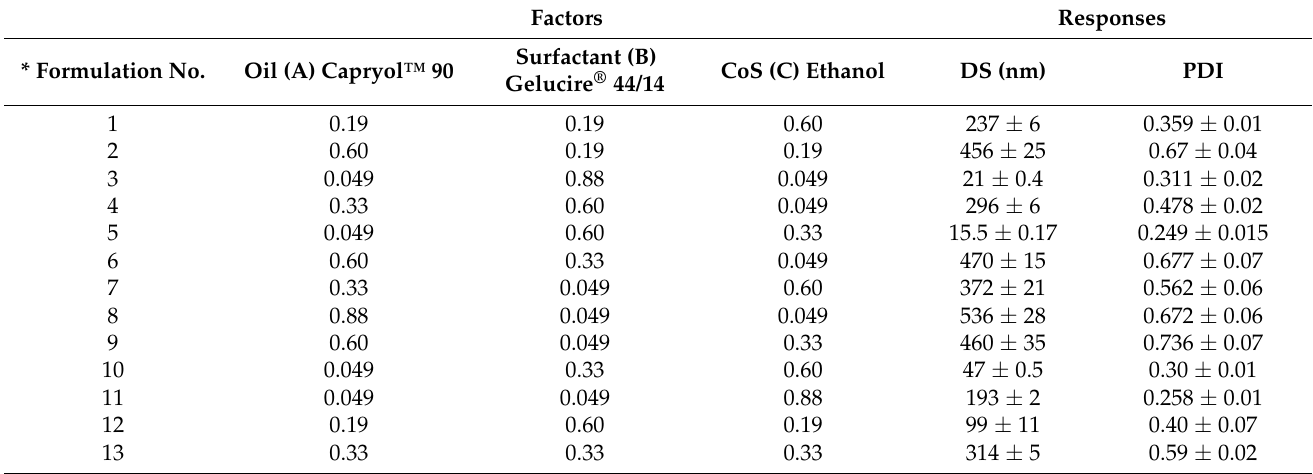
Table 3. Experimental runs suggested by simplex lattice mixture design approach for the optimization of Fr-SNEDS and the determined responses. Data are expressed as mean ± SD ( n =